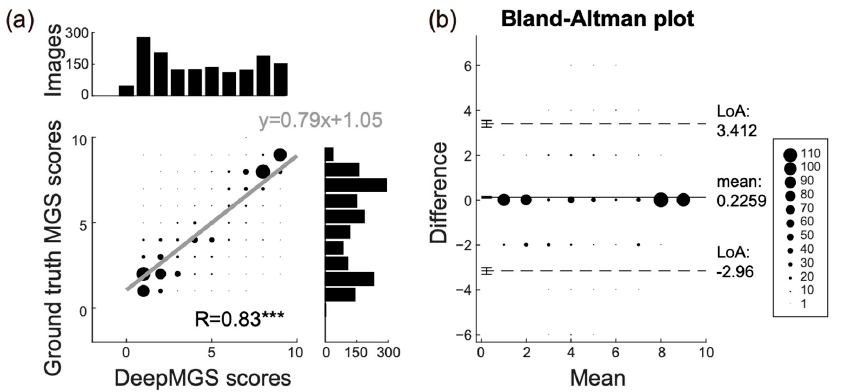
Figure 3. Comparison of the performance of the DeepMGS with the ground truth in the total MGS score prediction. ( a ) The linear regression analysis shows a high correlation coefficient (R = 0.83, p < 0.001) in the performance between DeepMGS and ground truth. The x -axis of linear regression represents the total MGS score predicted by the DeepMGS, and the y -axis represents the ground truth. The black bars represent the number of images with a total MGS score from 0 to 10. The size of dots represents the number of images in each data point. The three asterisks represent p < 0.001. ( b ) The Bland–Altman analysis indicates that 93% of the images are within the limits of agreement, which range from − 2.96 to 3.412. This result supports a favorable performance of DeepMGS.